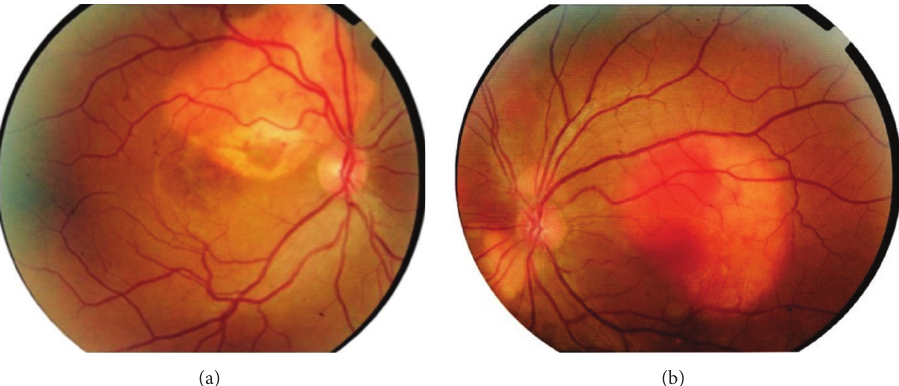
Figure 1: Fundus photography disclosed three foci of subretinal tumors in the left eye and large well-defined tumor in the macular area of the right eye with variable color due to decalcification, CNV, and SRF.